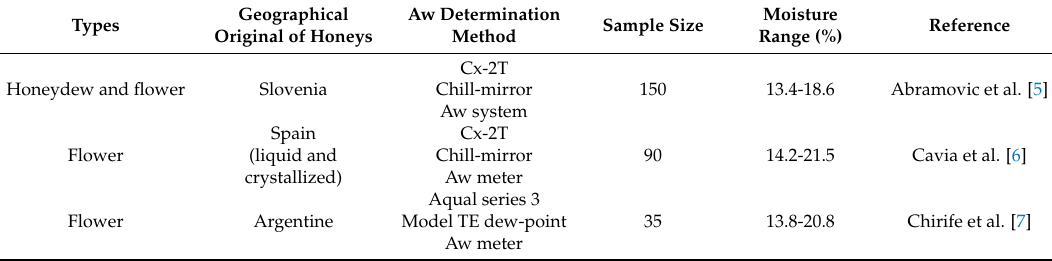
Table 1. Selected studies on the relationship between water activity and moisture content in honey.